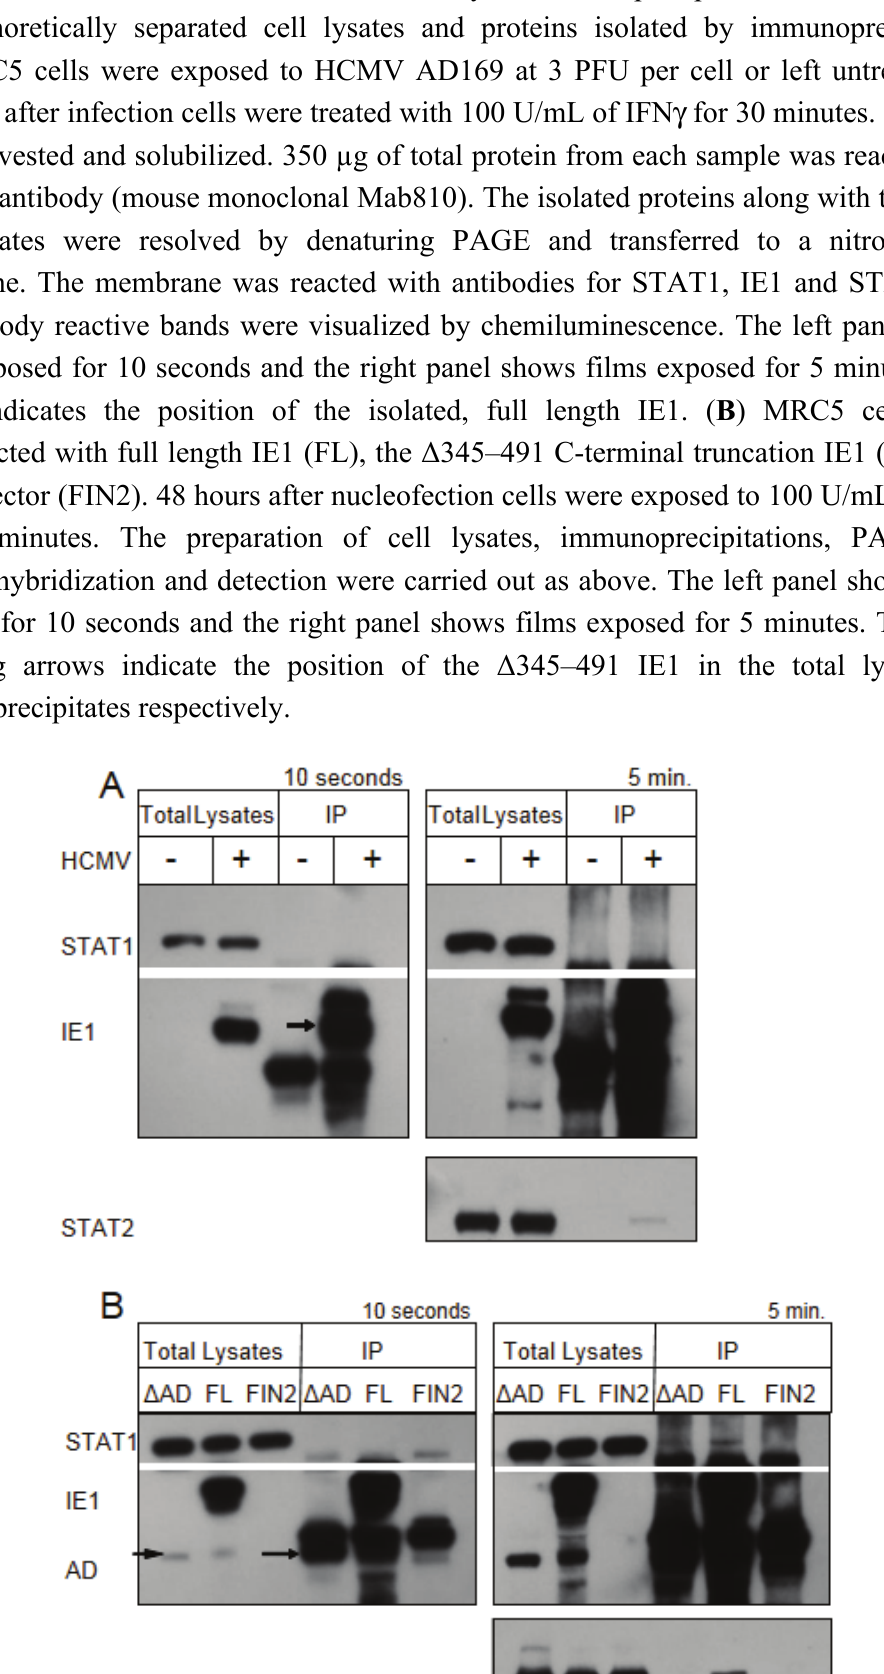
Figure 7. IE1 does not interact with STAT1 by co-immunoprecipitation. Film images of electrophoretically separated cell lysates and proteins isolated by